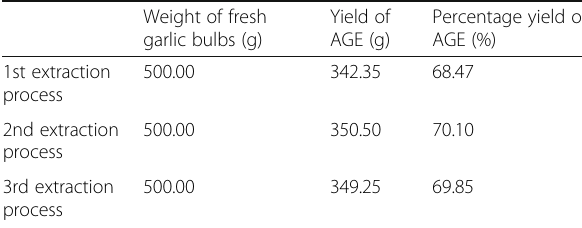
Table 2 Percentage yield of AGE Weight of fresh garlic bulbs (g)